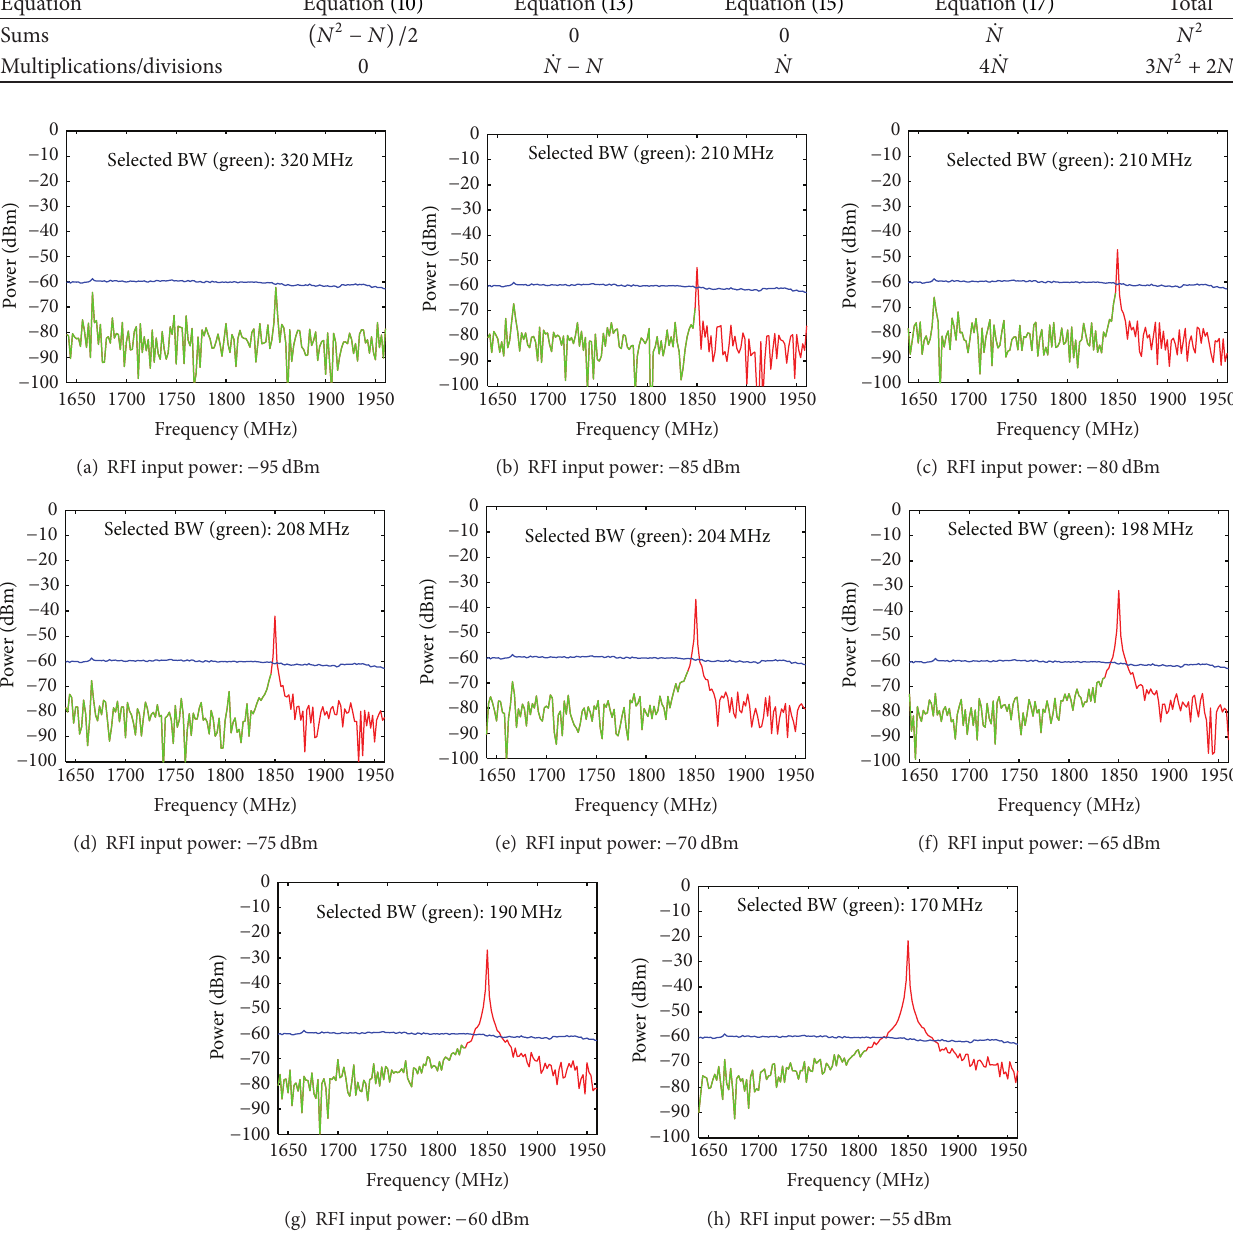
Figure 6: Power spectra of the narrowband RFI. The blue line shows the target response (displayed for comparison with RFI). The red line shows the RFI. The green line is overlaid onto the red line and indicates the subband selected by the SS-MO